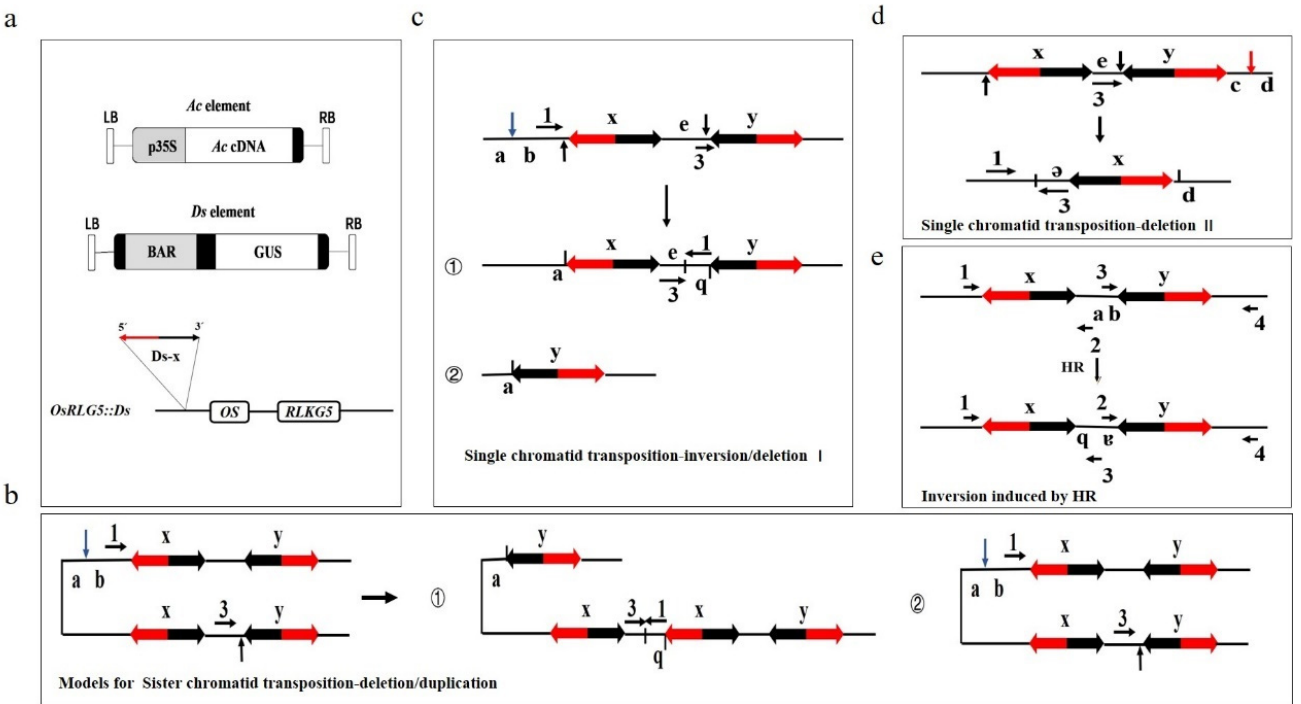
Figure 1. Models for transposon Ac/Ds -induced chromosomal rearrangements. ( a ) Models of Ac and Ds T-DNA vectors and the OsRLG5::Ds allele. ( b ) Models of sister chromatid transposition-deletion/duplication. ( c ) Models of single chromatid transposition-inversion/deletion Ⅰ . ( d ) Models of single chromatid transposition-deletion Ⅱ . ( e ) Models of the homologous recombination of the chromatid. The 3 (cid:48) and 5 (cid:48) ends from two different Ds elements were re-inserted into the OsRLG1- 36 region after being cut by the Ac transposase, which is known to be the alternative transposition [29]. OsRLG1-36 homologous genes encoding receptor-like kinases clustered on the short arm of rice chromosome 1. One line, OsRLG5::DS , was isolated by screening region of OsRLG5 (Receptor Like Kinase Gene 5) (Figure 1a), which is related to Leaf rust resistance 10 ( Lr10